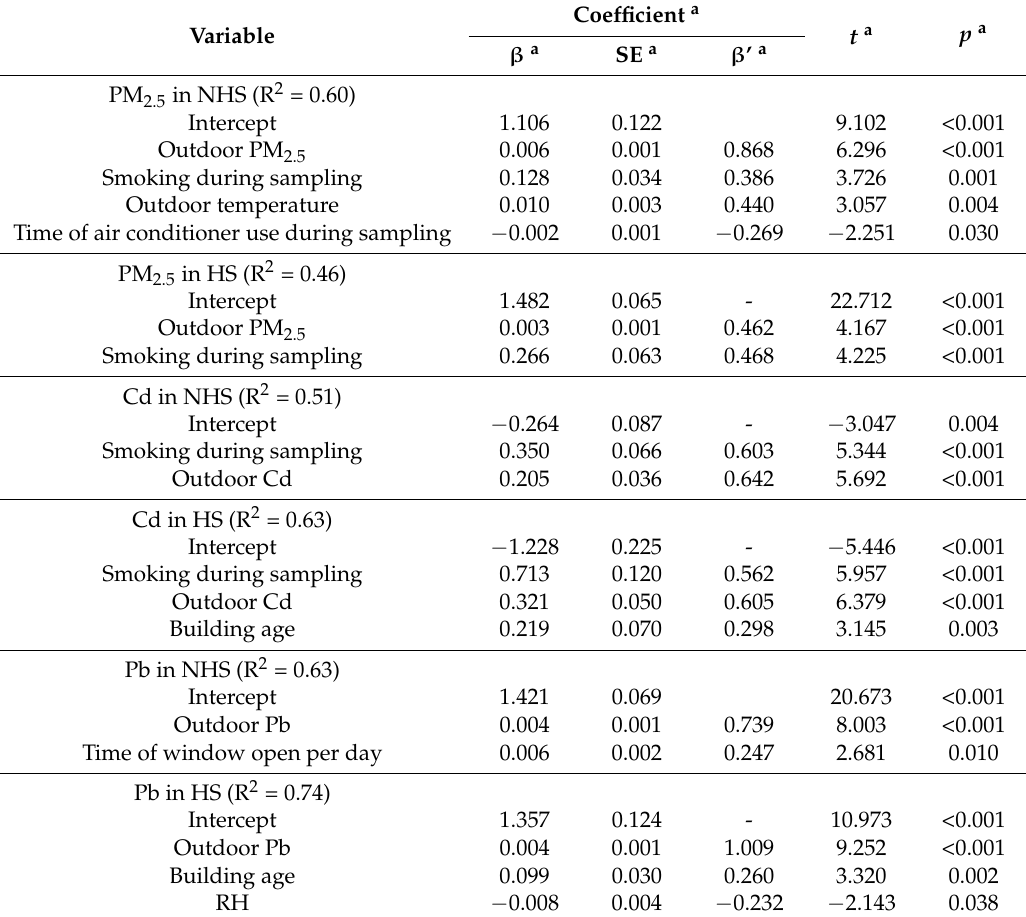
Table 7. Multiple linear regression of indoor PM 2.5 and selected elements and their potential influencing variables.